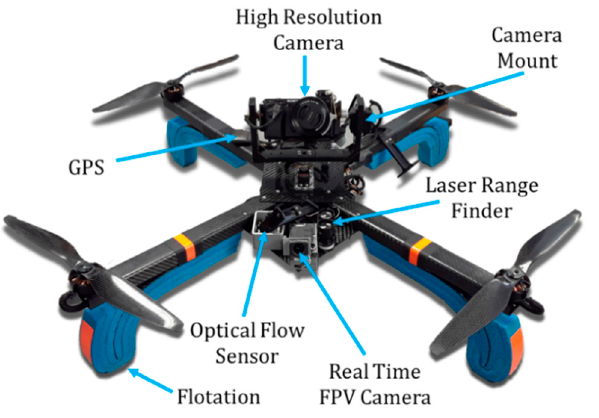
Figure 1. Proposed hardware configuration of bridge inspection UAS.